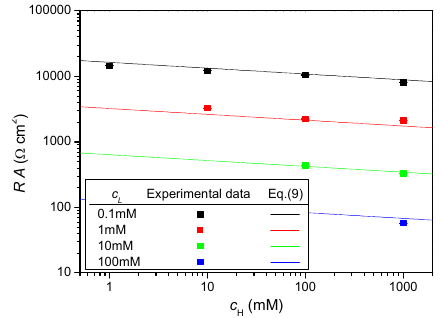
Figure 9. Area ‐ specific resistance for various concentrations of both NaCl solutions Figure 9. Area-specific resistance for various concentrations of both NaCl